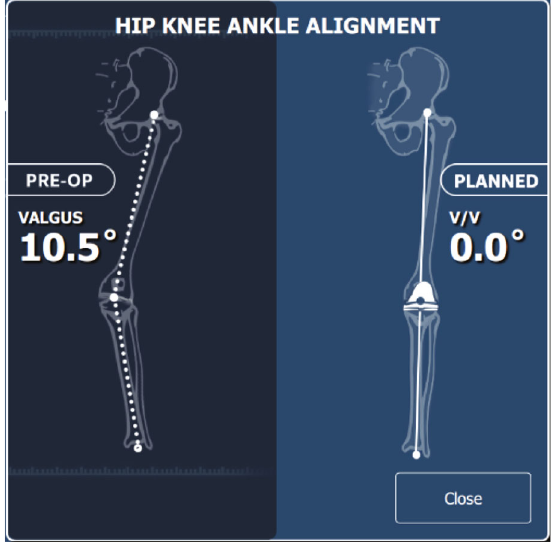
Figure 18: The initial evaluation (left) of 10.5 valgus in extension, and the planned HKA correction (right) for Case